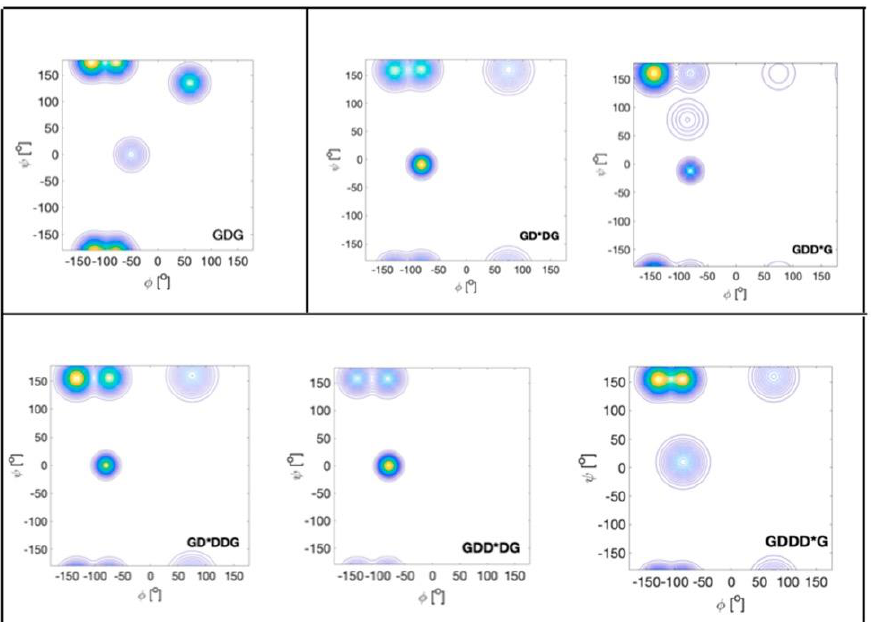
Figure 12. Ramachandran plots of non-terminal (D) residues of the indicated fully protonated oligo-L-aspartic acid peptides. Figure reproduced from [101] with permission, 2021, American Chemical Society.